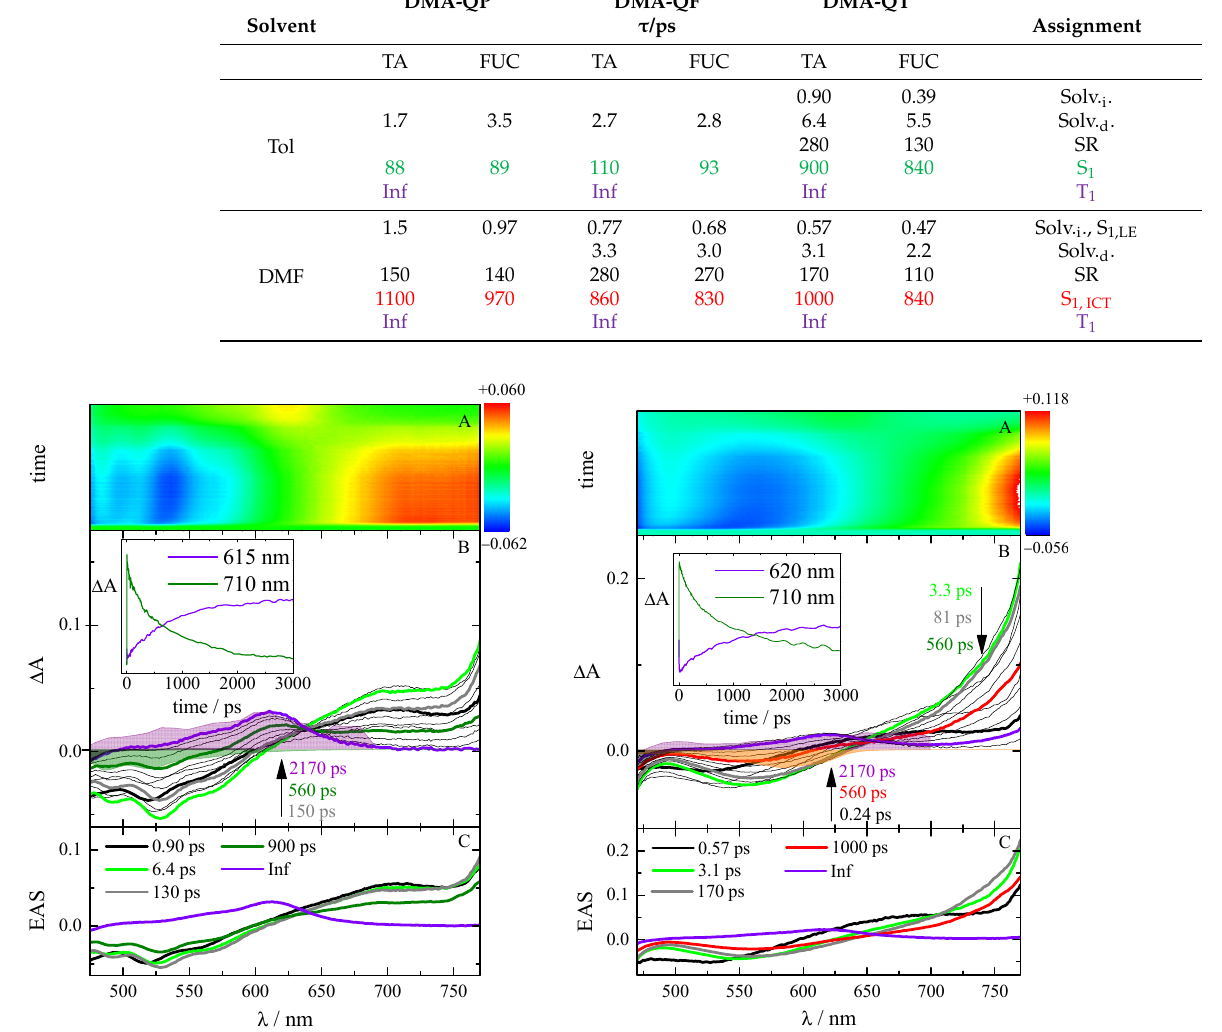
Figure 6. Femtosecond transient absorption measurements of compound DMA-QT in Tol ( left ) and DMF ( right ) obtained by pump-probe experiment ( λ exc = 400 nm). Panel ( A ), experimental 3D matrix reporting color-coded ∆ A as a function of wavelength and time; Panel ( B ), representative spectra at different delay times and representative kinetics (inset) at different wavelengths, together with steady-state absorption (gray-shaded area), emission (green-shaded area or orange-shaded area), and triplet TA spectra (purple-shaded area as obtained by ns laser flash photolysis shown below); Panel ( C ), EAS (excited associated spectra) obtained by global analysis.